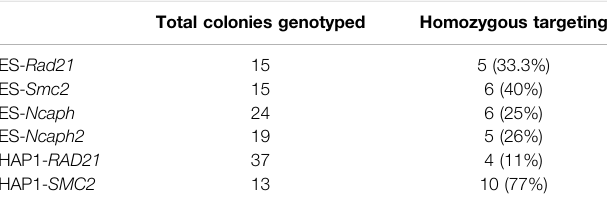
TABLE1| Genetargetingef fi cienciesinmESCandHAP1clonesintheexampleof the AtAFB2 system. Total colonies